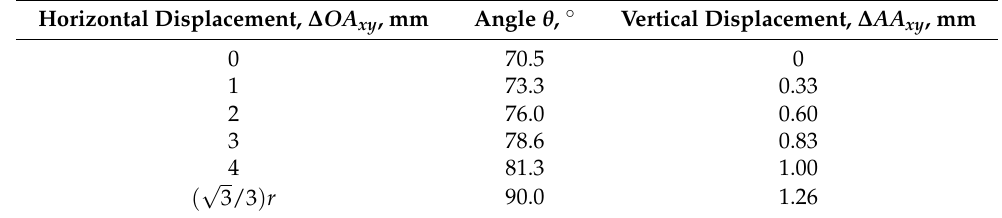
Table 1. The calculated angle θ based on the geometrical relationship.